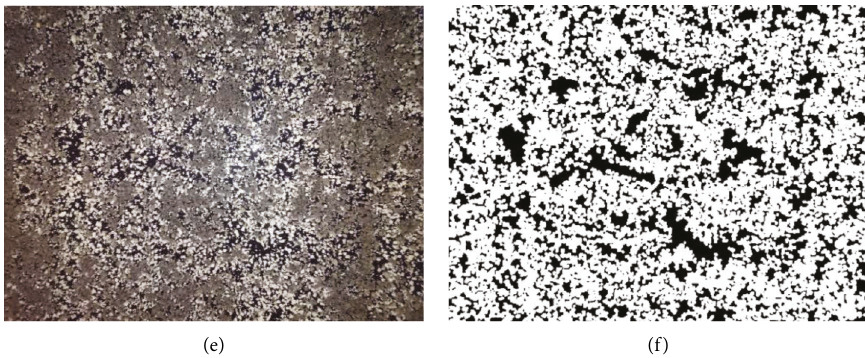
Figure 18: Original and inspection images of the actual spreading